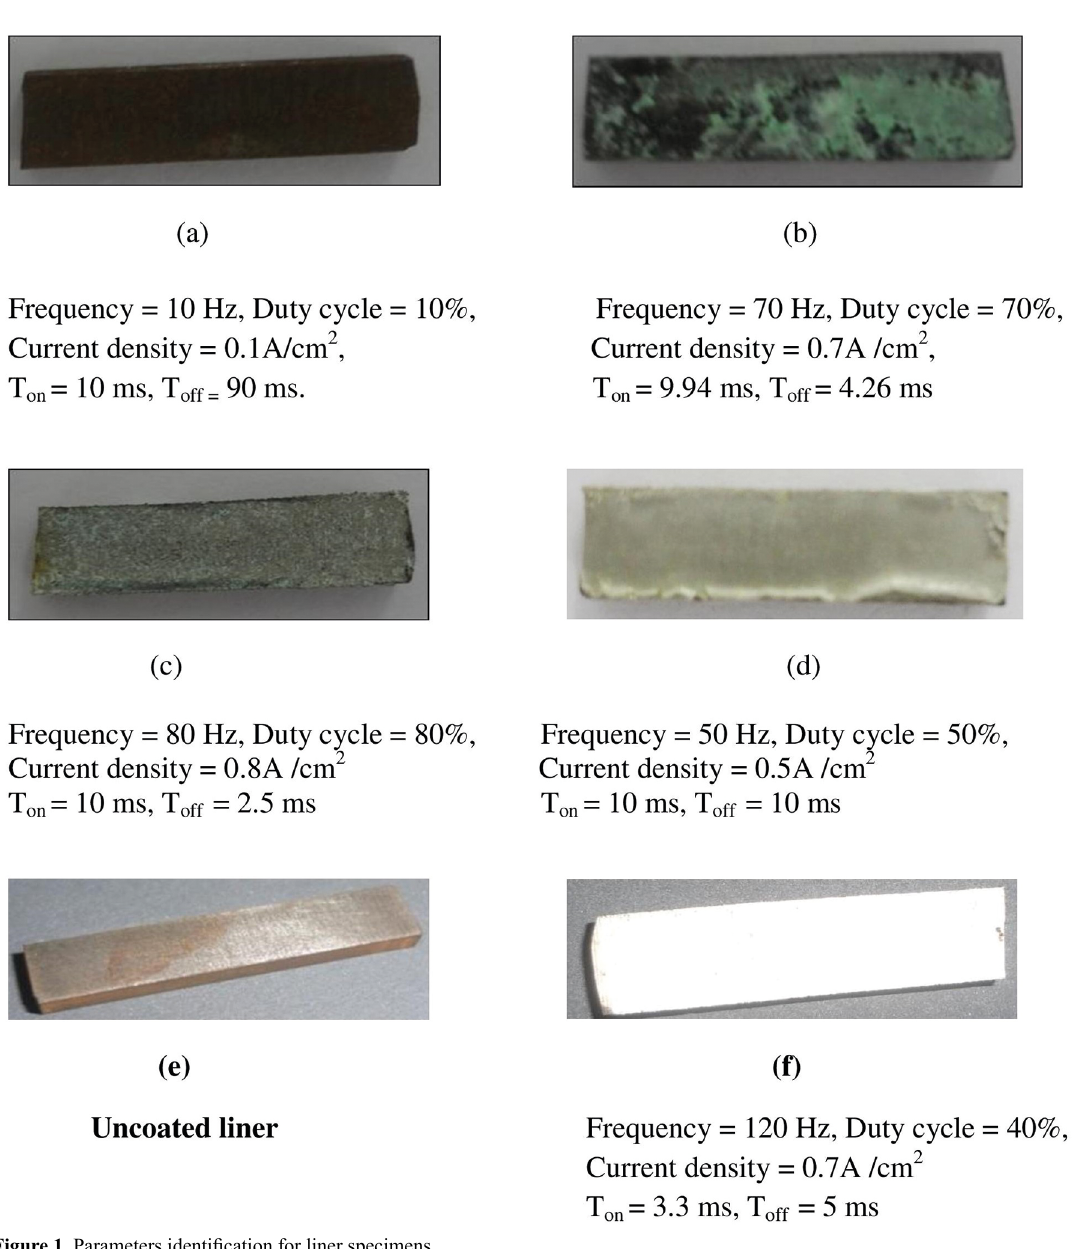
Figure 1. Parameters identification for liner specimens.